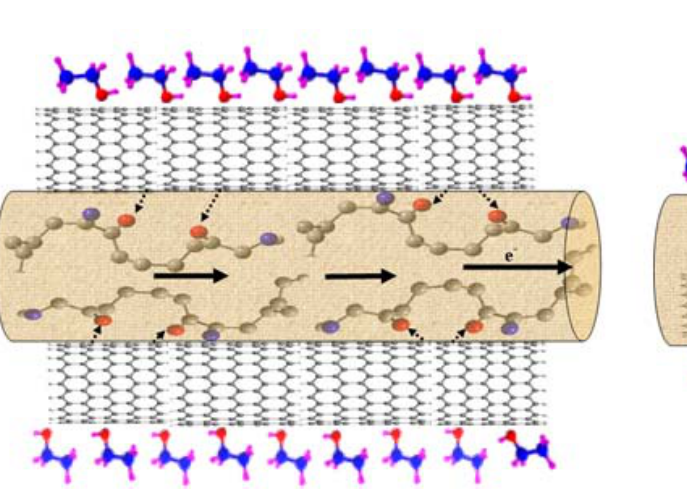
Figure 11. Schematic representation of (A) sa MWCNTs/Nylon-6 nanofibers composite and (B) im MWCNTs/Nylon-6 nanofibers during the exposure to an analyte